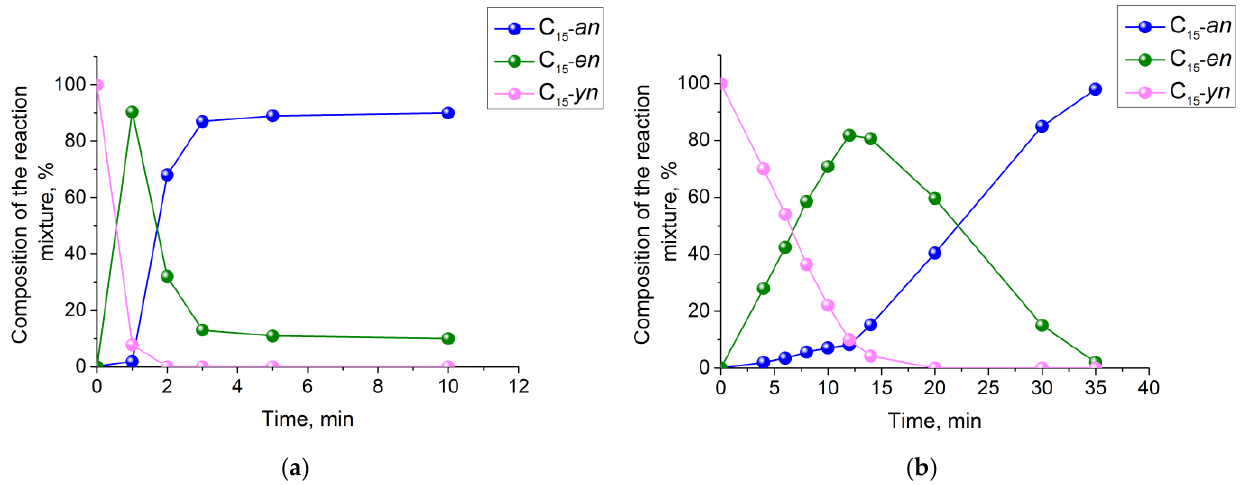
Figure 8. Changes in the composition of the reaction mixture during the hydrogenation of 3,7,11-trimethyldodecyn-1-ol-3 (C 15 -yn) to 3,7,11-trimethyldodecen-1-ol-3 (C 15 -en) and 3,7,11-trimethyldodecan-1-ol-3 (C 15 -an) in the presence of 1%Pd-PVP/ZnO ( a ) and 1%Pd/ZnO ( b ). Reaction conditions: T = 40 °C, P H2 = 1 atm, m cat = 0.05 g, solvent C 2 H 5 OH 0.25 mL, and C alkynol = 0.09 mol/L.